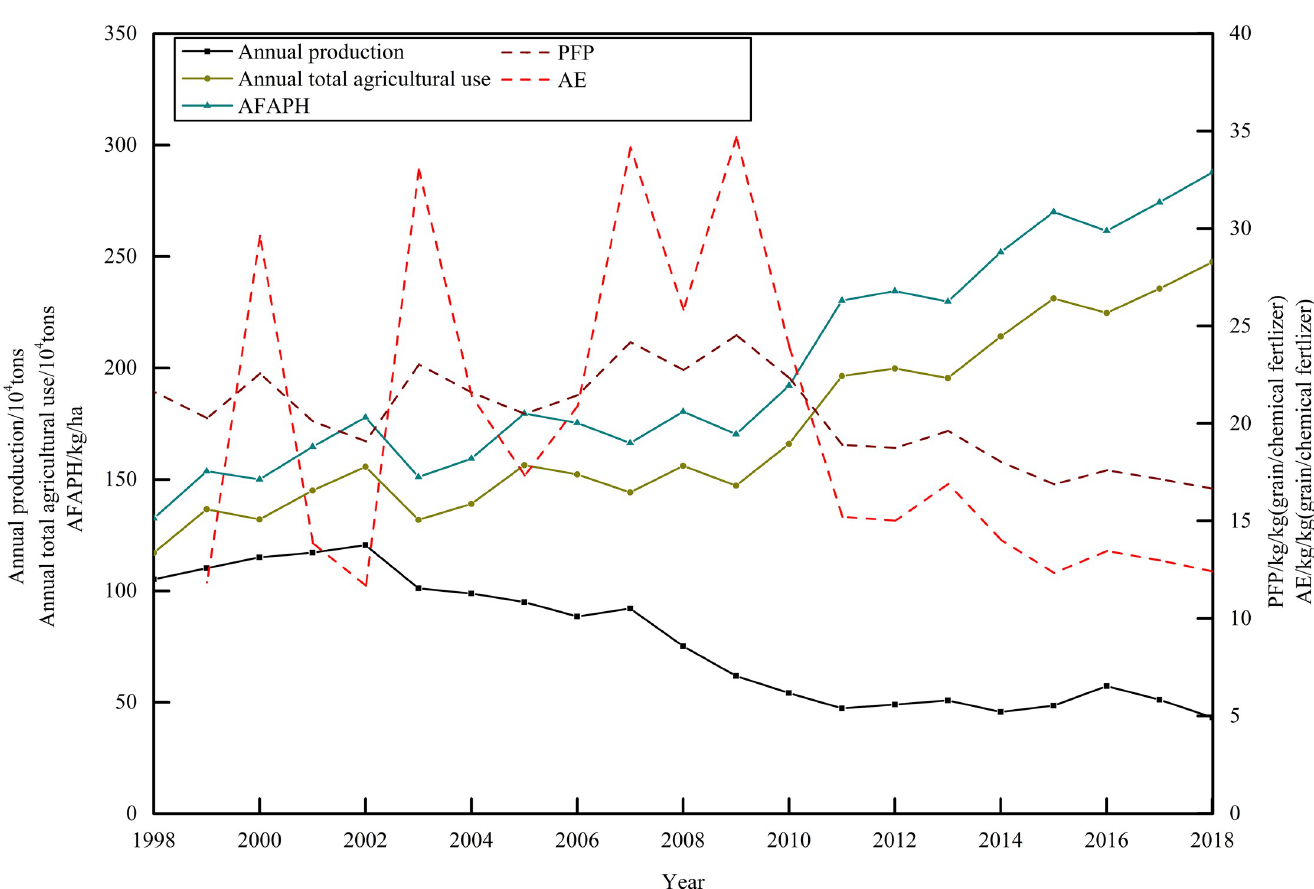
Fig 8. Fertilizer application in Bangladesh from 1998 to 2018. The line charts of the main coordinate axis represented the annual production of chemical fertilizer, the annual total agricultural use of chemical fertilizer and the average fertilizer application rate per hectare (AFAPPH). The line charts of secondary axis represented partial factor productivity (PFP) and agronomic efficiency (AE) of applied chemical